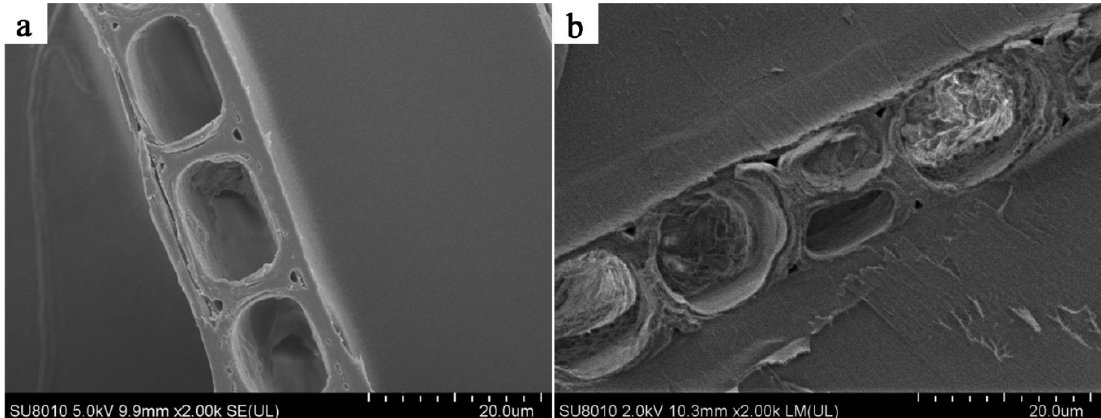
Figure 4. SEM photos of wood sample: ( a ) control; ( b ) impregnated.